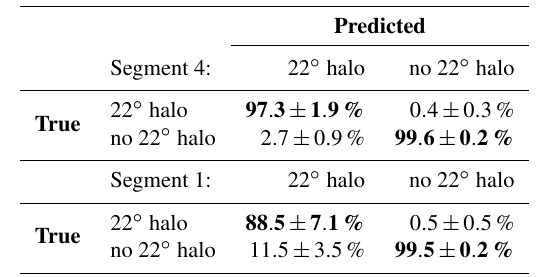
Table 3. Confusion matrix for HaloForest for the uppermost (no. 4) and lowermost (no. 1) image segments. The label “Predicted” refers to the class which was predicted by HaloForest, whereas “True” la- bels the visually identified class. The true positives (correctly clas- sified “22 ◦ halo”) are printed in bold font. False positives (“no 22 ◦ halo” classified as “22 ◦ halo”) and false negatives are listed on the other diagonal. The results are provided with a 2 σ standard